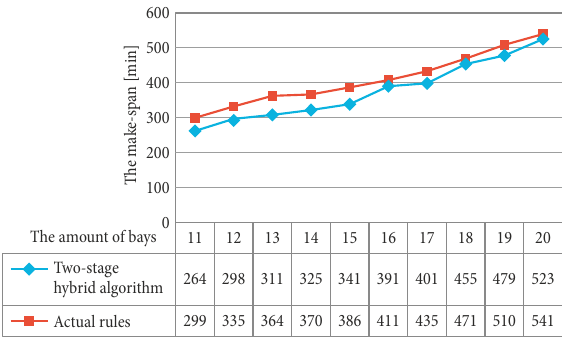
Fig. 9. Comparison of make-span between two-stage hybrid algorithm and actual rules for large-sized